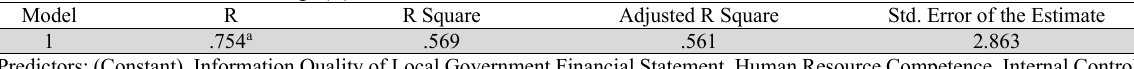
Determination Coefficient Eq. (2)